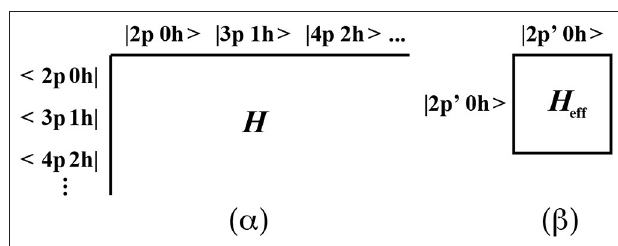
FIGURE 3 | Representation of the matrices H and H eff for 18